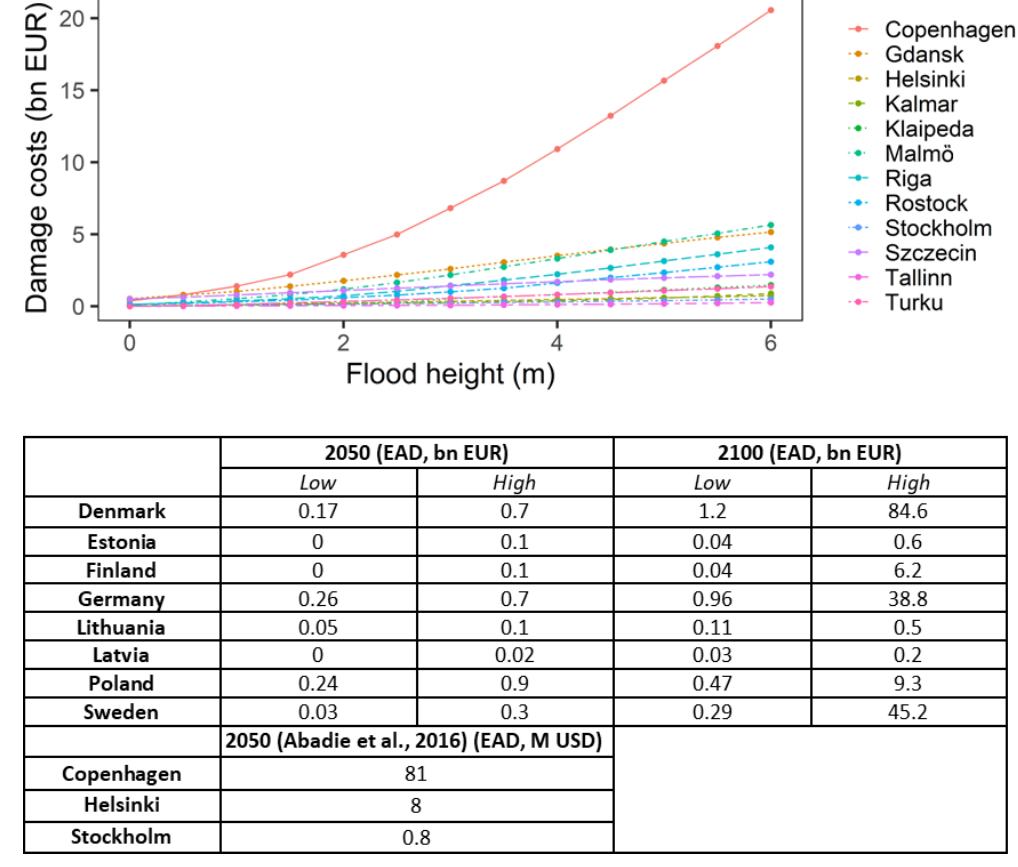
Figure 11. Estimated damage cost curves for a coastal flood event for select cities along the Baltic Sea based on Prahl et al. (2018). The insert shows high and low estimates of the cost of expected annual damage (EAD) to Baltic countries from extreme water levels by Vousdoukas et al. (2018, 2019, 2020) as well as specific estimates for major Baltic cities in 2050 by Abadie et al. (2016). Note that the former is in billions of EUR, whereas the latter was estimated in millions of